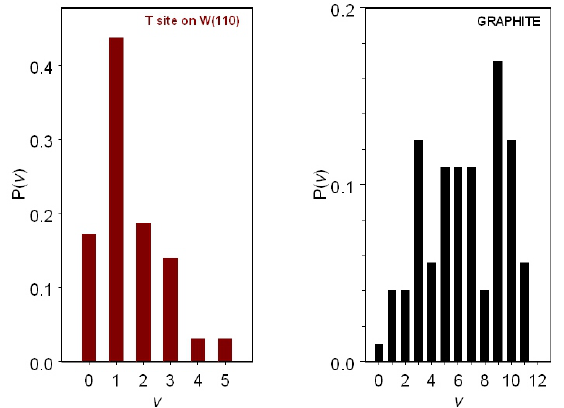
Figure 6. Vibrational distributions for H 2 ( v ) molecules formed on the T site on W(110) and